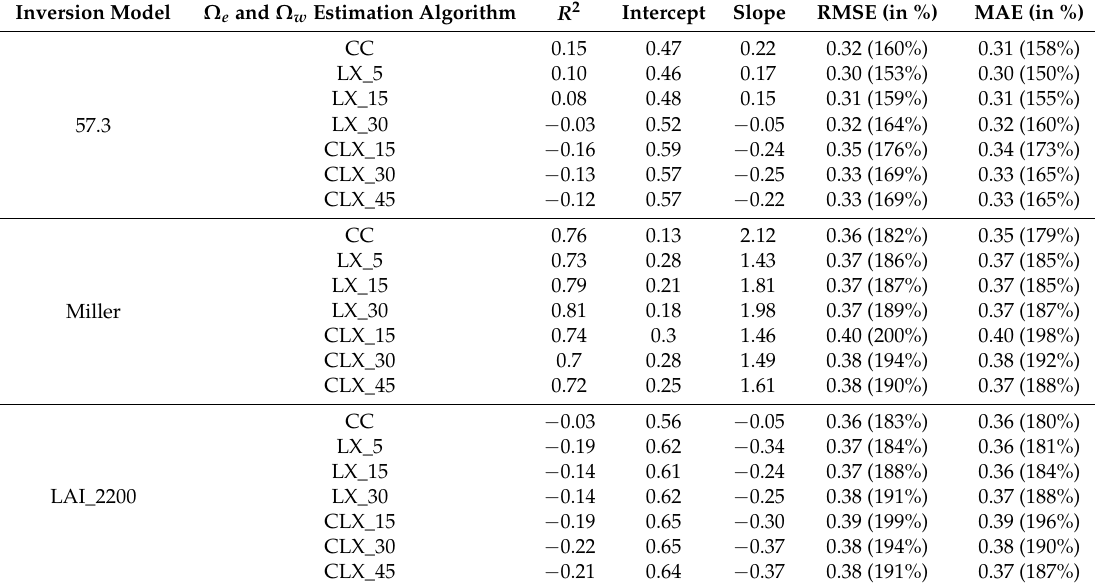
Table 9. Correlation statistics between the obtained α (estimated with consideration of Ω e and Ω w by using the leaf-on and leaf-off periods DHP images) and the reference α of the five plots. Statistics are given at the 95% confidence level from the two-tailed Student’s t -test.